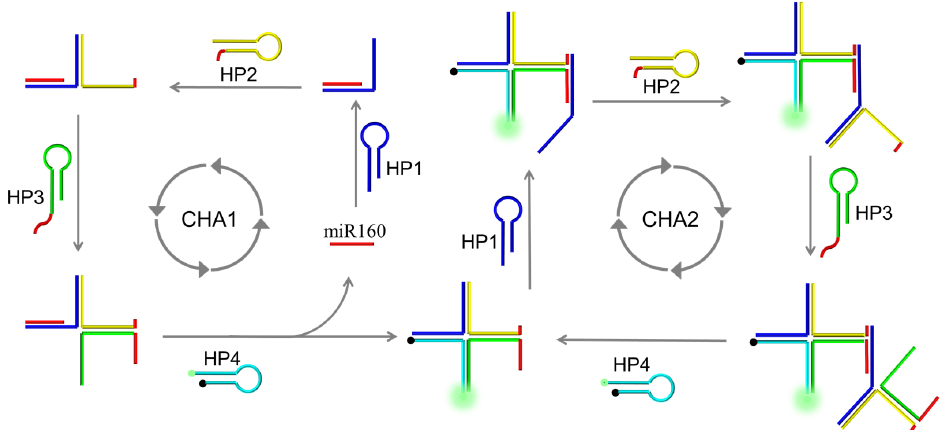
Figure 1. A schematic diagram of experimental principles of the AMM system for plant miRNA160 detection. The AMM system contains two catalytic hairpin assembly (CHA) processes. CHA1: In the presence of the target, HP1 is dissolved and releases the 3 ′ end of HP1 that hybridizes with HP2 and releases the 3 ′ end of HP2. Similarly, the hairpin-shaped HP3 is opened and subsequently hybridizes with HP4. The released 3 ′ sequence of HP4 can, in turn, bind to HP1, displacing the pre-hybridized target species and forming a four-way DNA junction (F-DJ). CHA2: Besides the released target initi- ating the next round of hybridization/displacement reactions, the red DNA fragments at the ends of HP2 and HP3 are brought together and serve as an integrated target analogue to initiate the second CHA